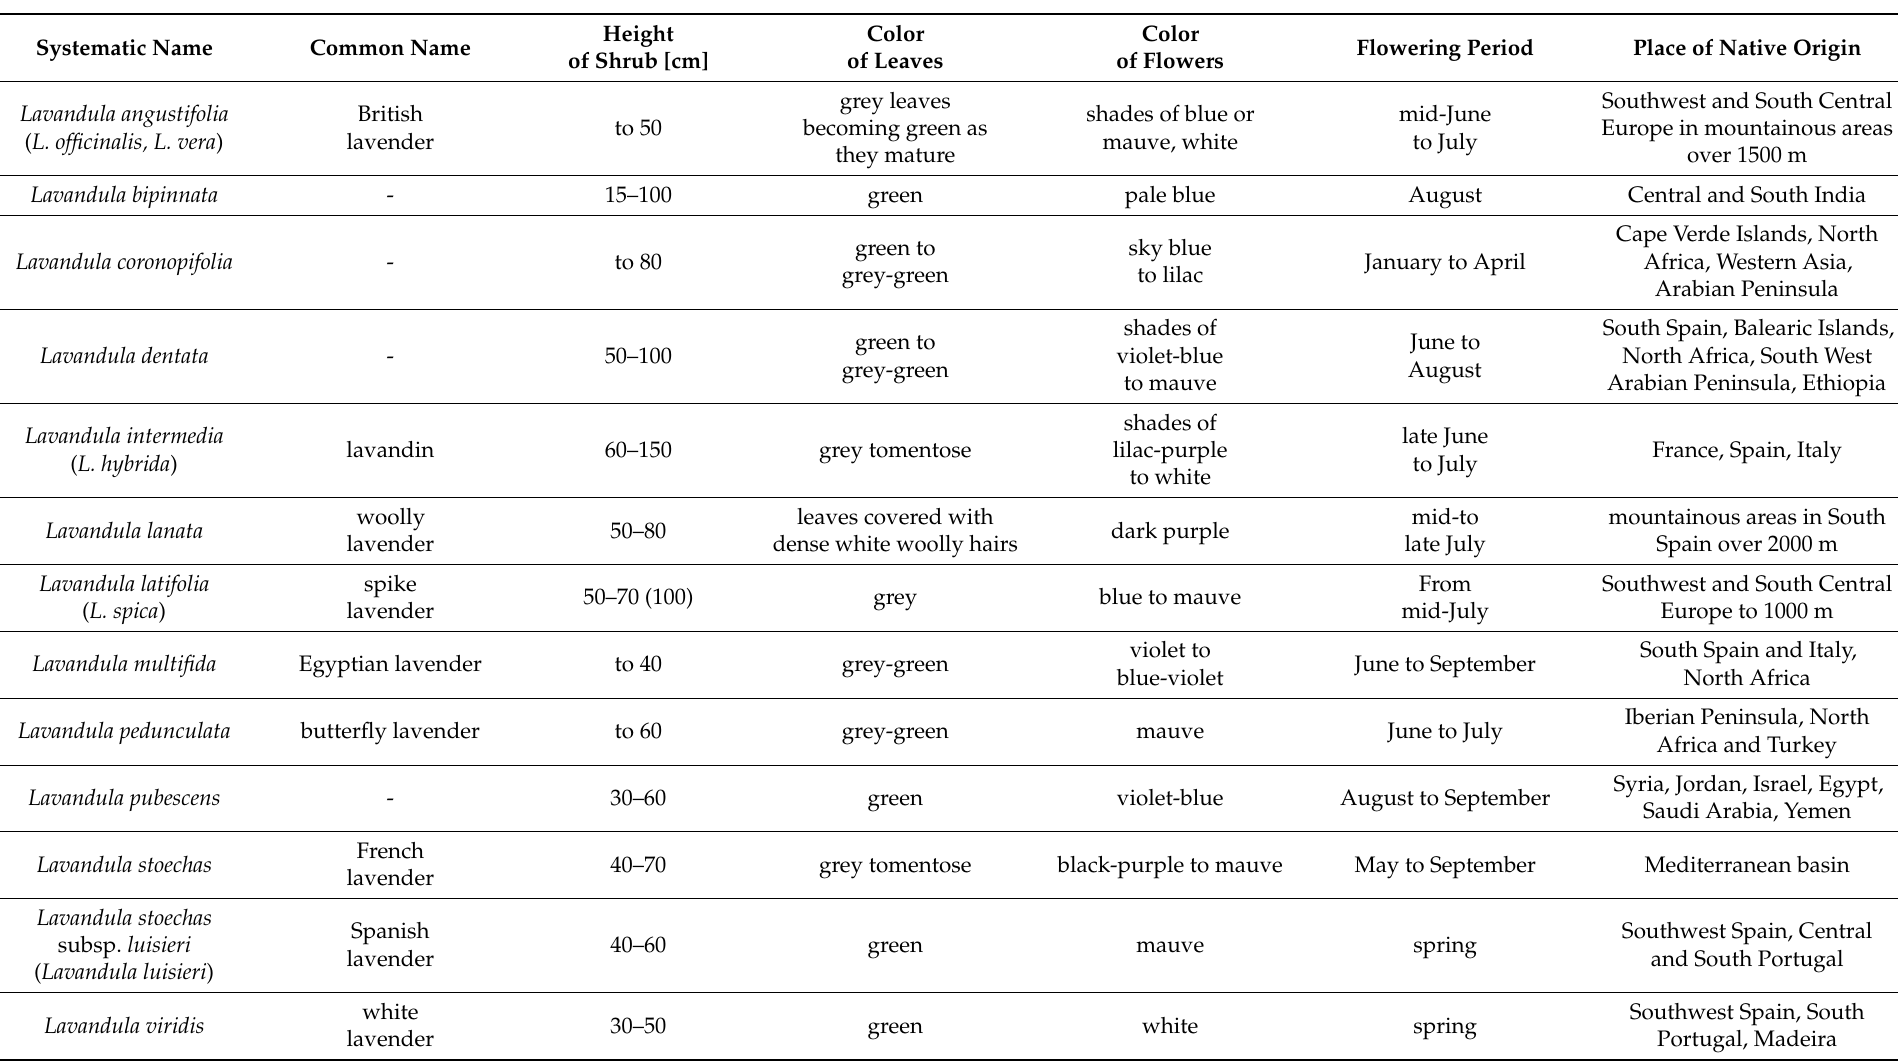
Table 1. The specific characteristics of different species of Lavandula